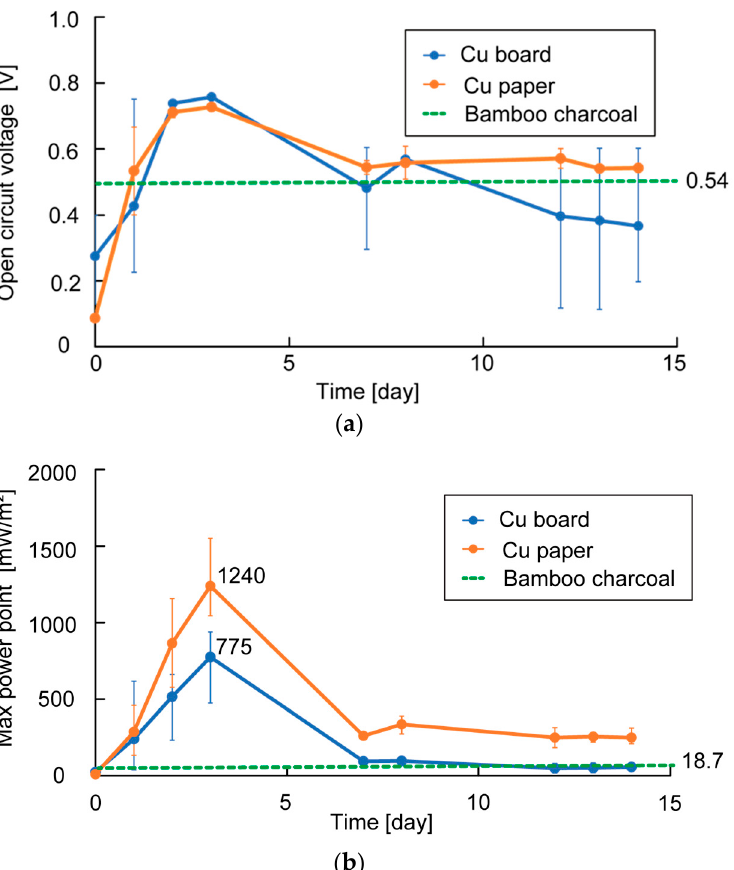
Figure 11. Measurement results of OCV and MPP of each electrode: ( a ) measurement result of OCV; ( b ) measurement result of MPP.